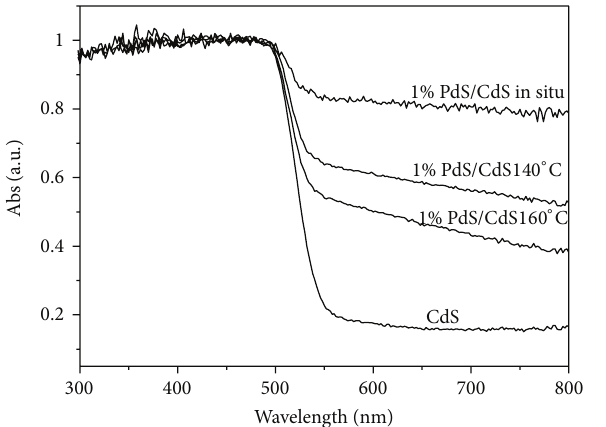
Figure 5: XRD patterns of PdS/CdS